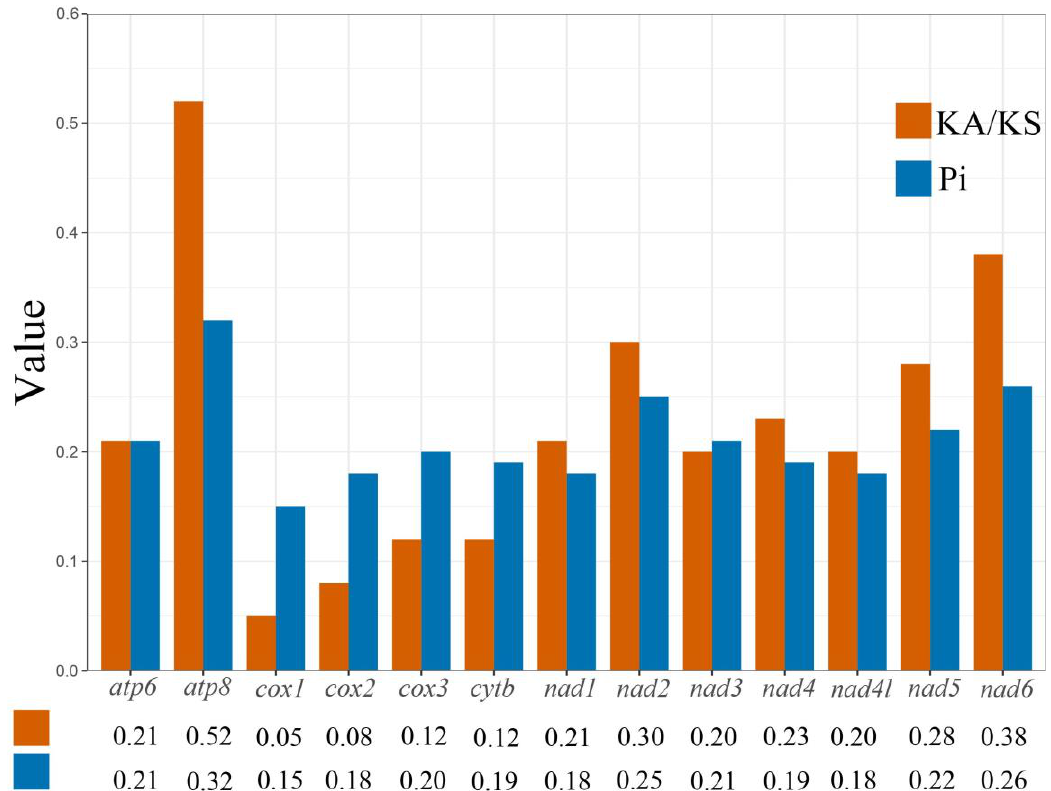
Figure 3. Nucleotide diversity (Pi) and nonsynonymous (Ka)/synonymous (Ks) mutation rate ratios of 13PCGs of Scolytoplatypus species (the Pi and Ka/Ks values of each PCG are shown under the gene name).